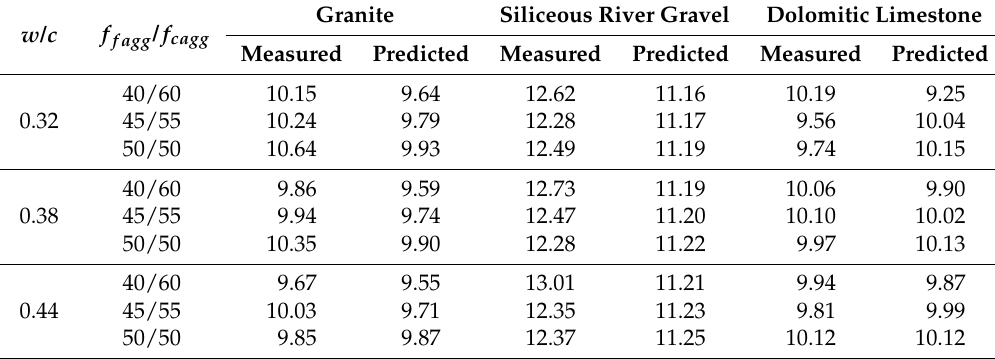
Table 4. Comparison of the model predicted with the experimentally measured thermal expansion coefficients by Sakyi-Bekoe [2] for concretes with granite, siliceous river gravel and dolomitic limestone as coarse aggregates (unit: 10 − 6 / ◦